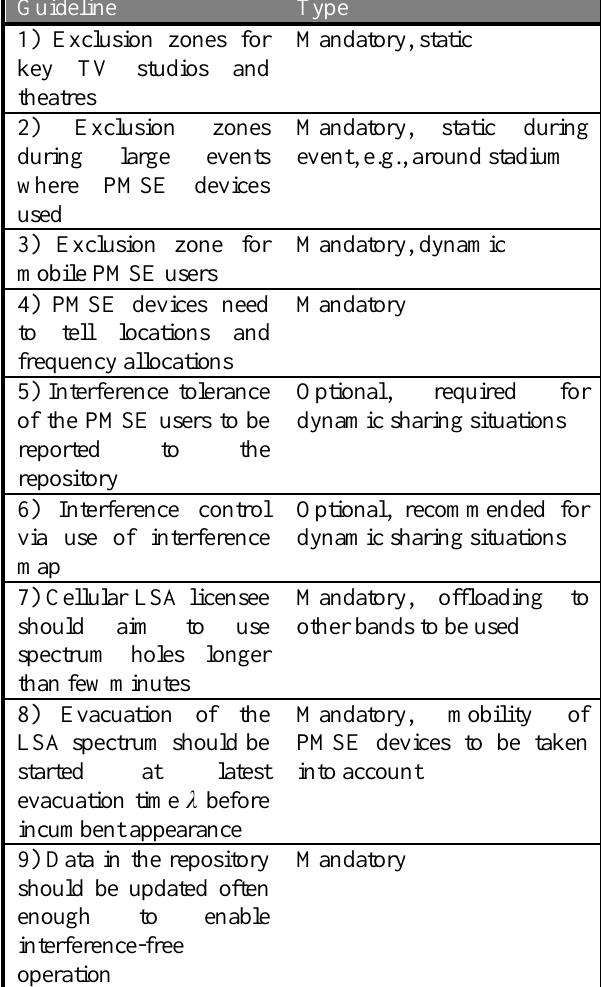
Table 1. Operational guidelines for